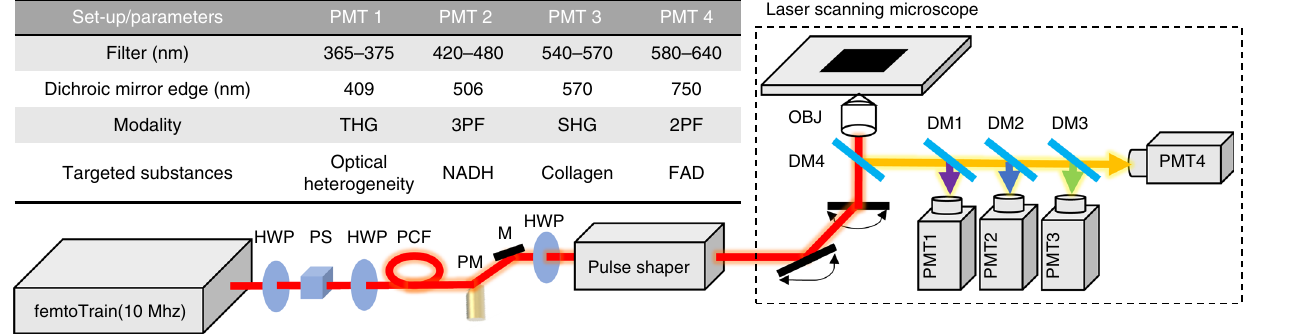
Fig. 1 Schematic of the SLAM microscopy platform. The high peak-power laser pulses were sent into the PCF to generate a supercontinuum. The pulse shaper is programmed to choose the excitation window (1080 – 1140 nm) and compensate the dispersion to make the output beam near-transform-limited. Different dichroic mirrors and optical fi lters are used in the detection system to collect spectrally resolved multimodal multiphoton signals by photomultipliers as speci fi ed in the table. DM dichroic mirror, HWP half wave plate, M mirror, OBJ objective, PCF photonic crystal fi ber, PM parabolic mirror, PS